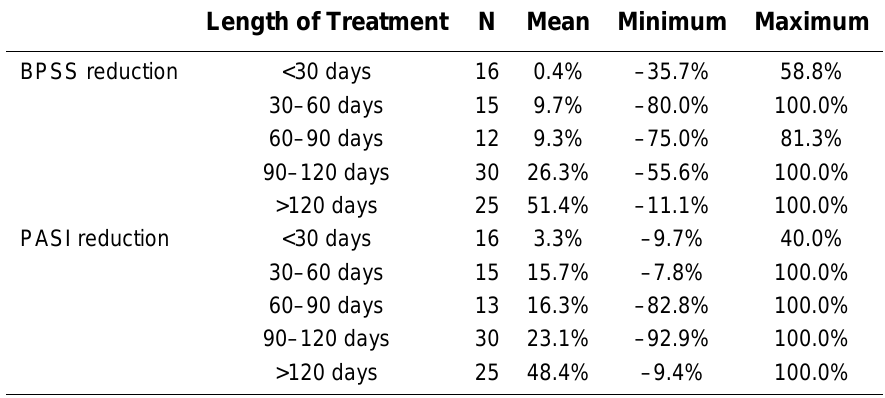
Assessment of Psoriasis Severity According to the Length of QoolSkin